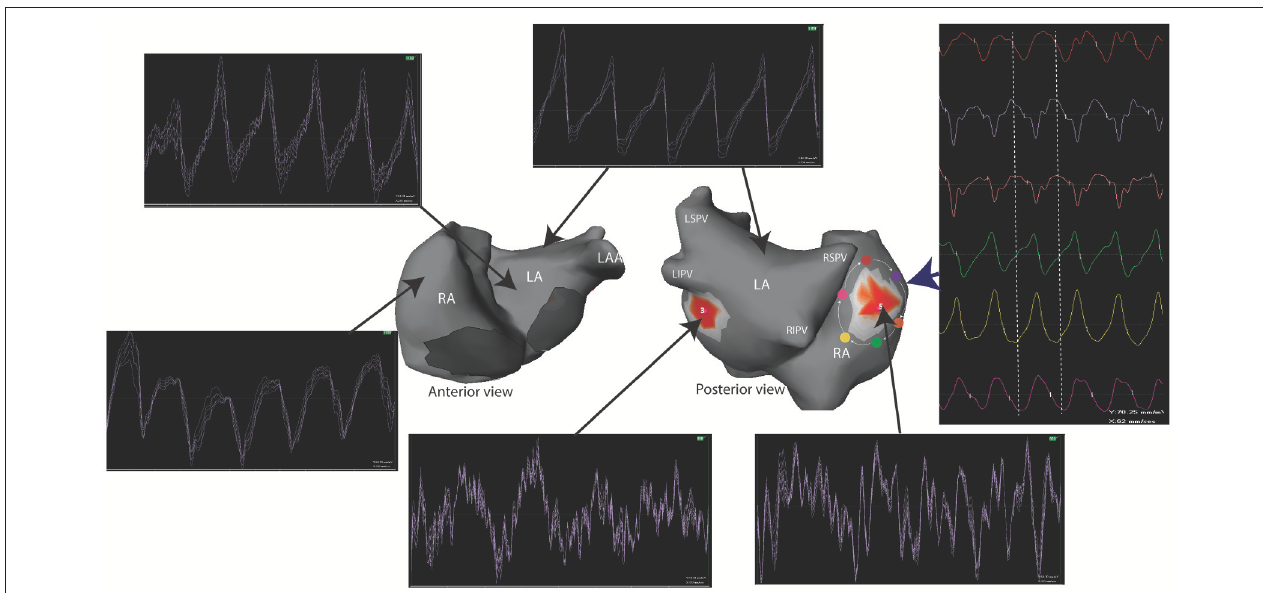
FIGURE 5 | Unipolar signals recorded during a one second window of AF. Electrograms at the site of reentrant activities (red spots) show a complex and turbulent activity while the activity in the remaining atria is homogeneous. A reentry can be identified by analyzing the surrounding electrograms (white arrows) that show a sequential temporal activation. LA, left atrium; LAA, left atrial appendage; LIPV, left inferior pulmonary vein; LSPV, left superior pulmonary vein; RA, right atrium; RIPV, right inferior pulmonary vein; RSPV, right superior pulmonary